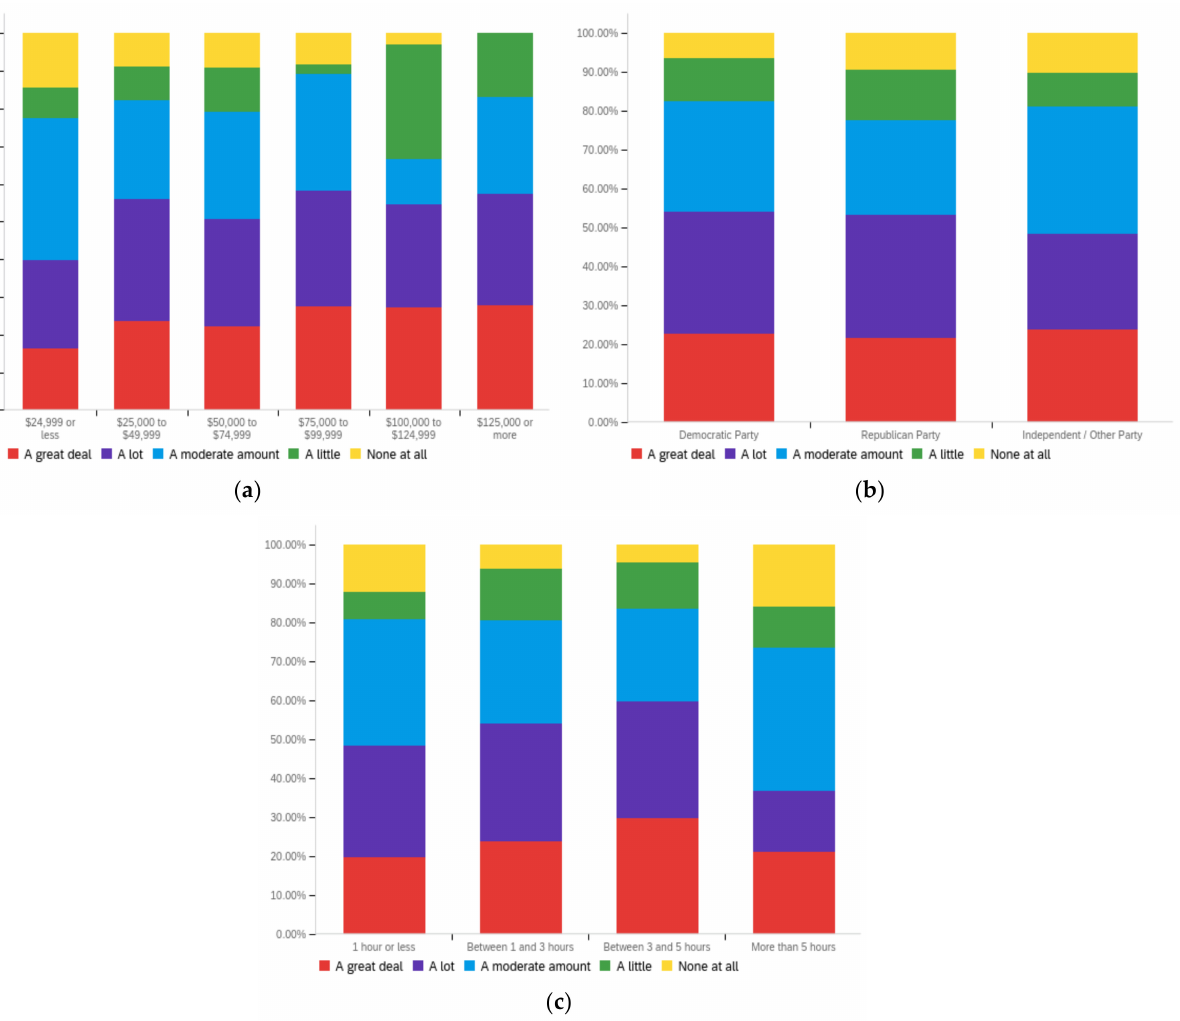
Figure A19. Article publisher’s political alignment—personal perception impact by: ( a ) income level (top left), ( b ) political affiliation (top right) and ( c ) online usage (bottom).